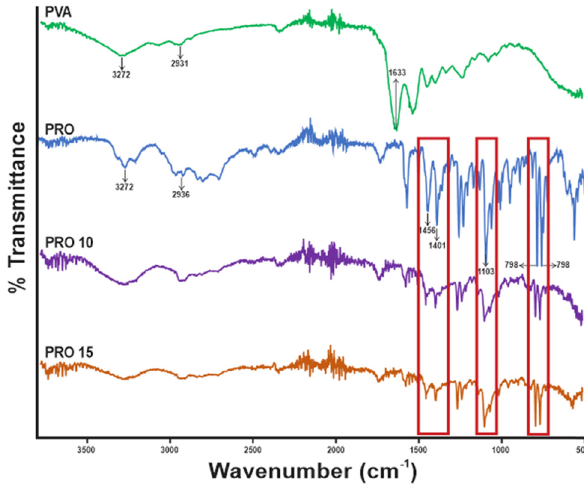
Figure 3: FTIR spectra of PVA, PRO, PRO 15, and PRO 10.